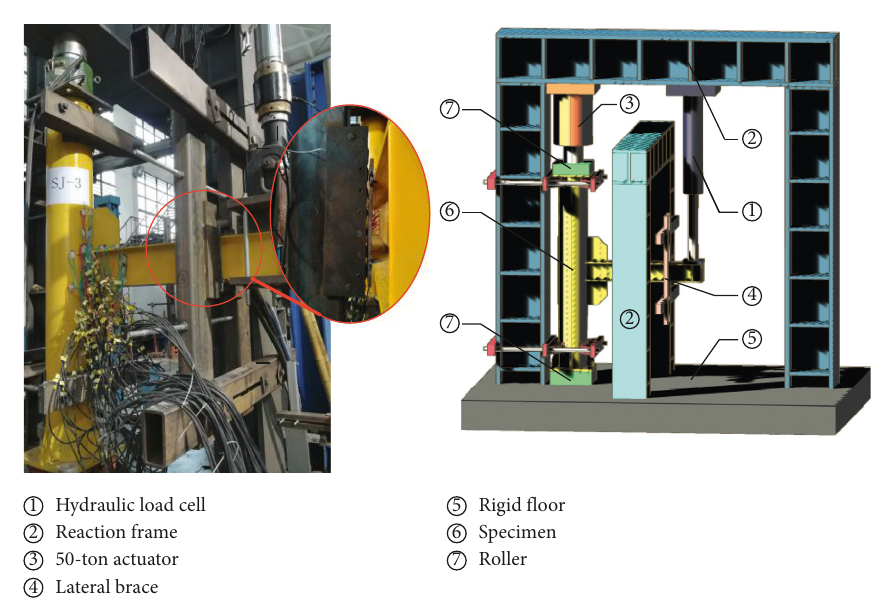
Figure 4: Experiment setup.